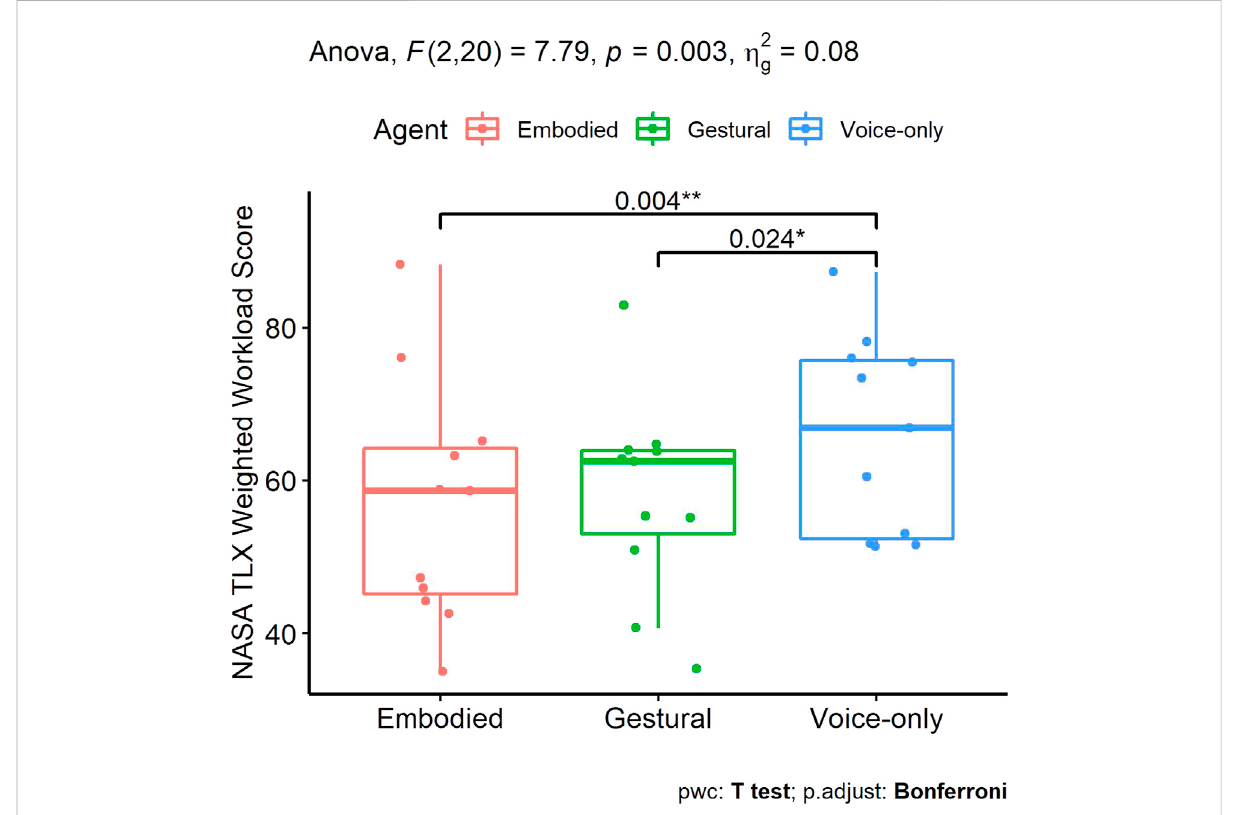
FIGURE 7 Results of the NASA TLX weighted workload (Statistical signi fi cance: *( p < 0.05), **( p < 0.01)).